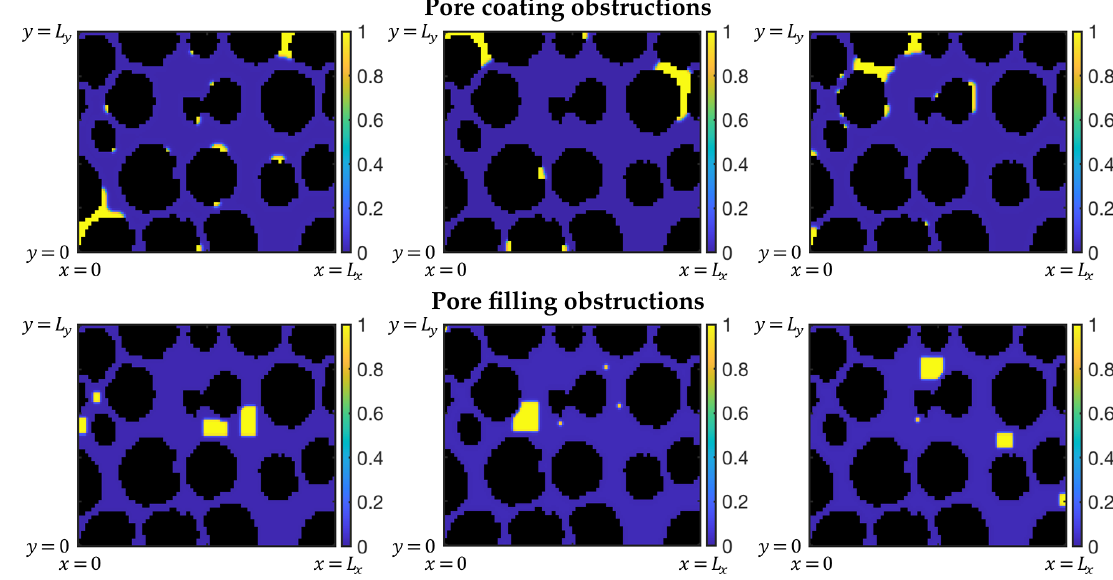
Figure 10. Contours of selected stationary solutions ψ ( i ) ( x , T ∞ ) , to (21) found with CLPS model from Section 4.3. The ( i ) solutions ψ ( i ) ( x , T ∞ ) are post-processed to give D o as described in Section